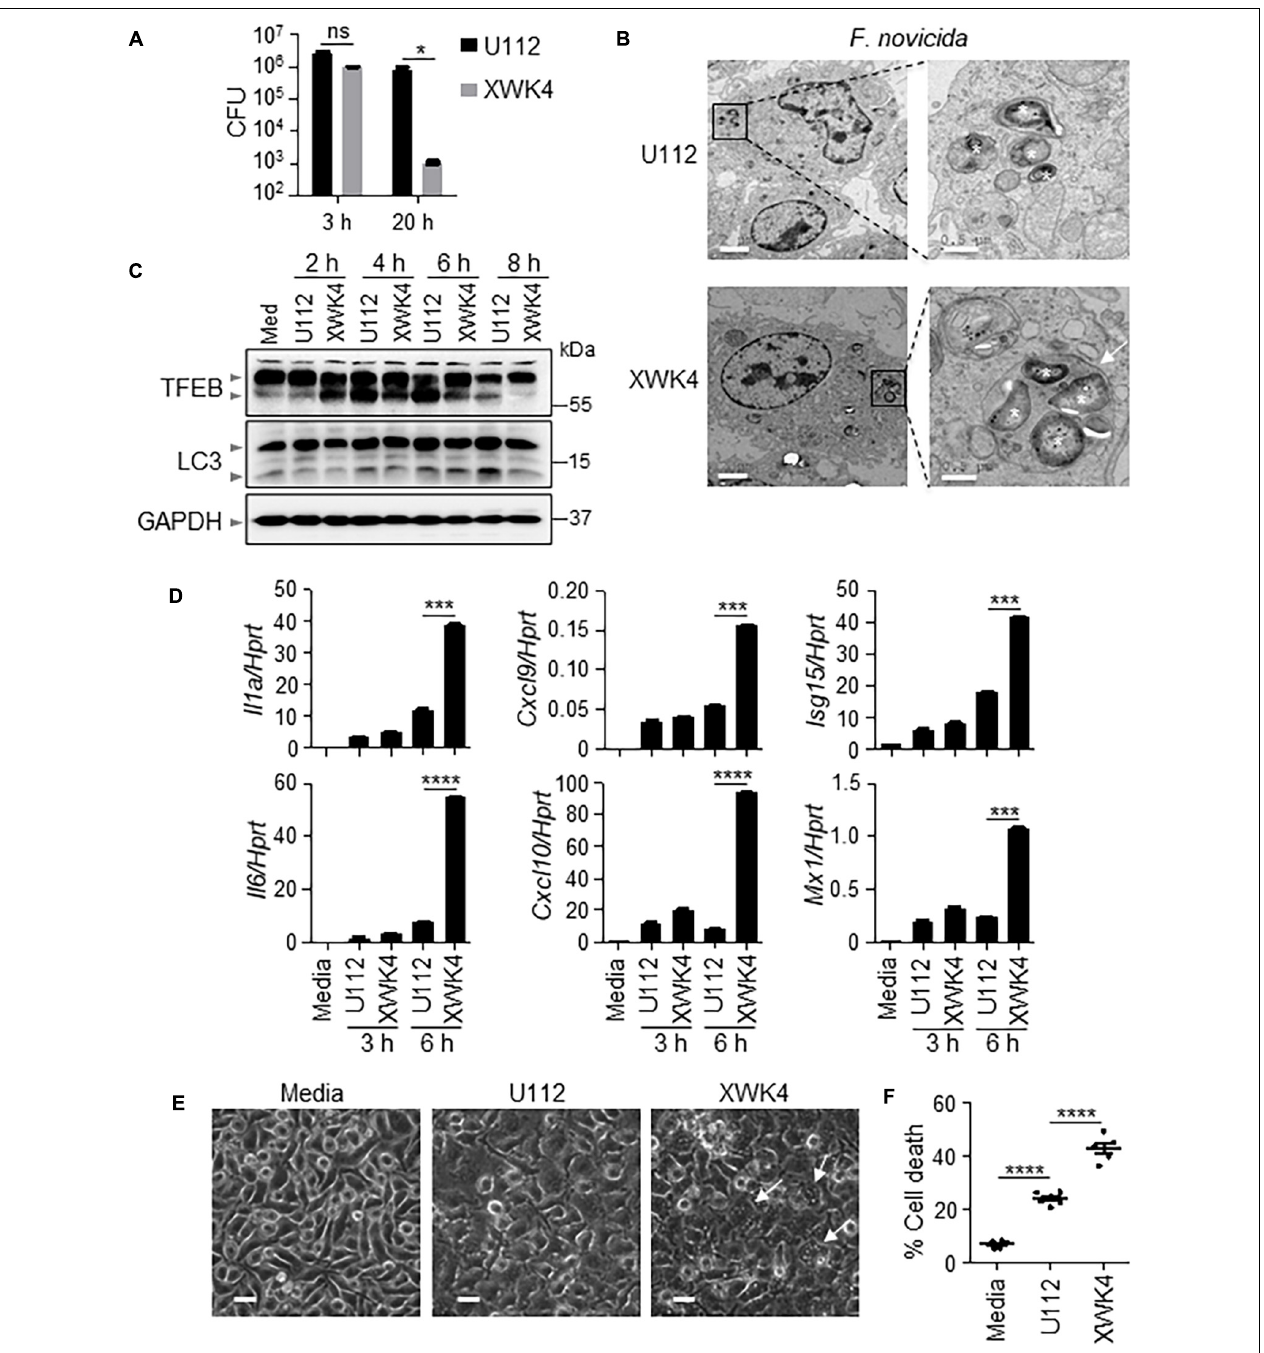
FIGURE 1 | F. novicida mutant strain XWK4 enhances inflammatory cytokines expression and cell death. (A) BMDMs from WT mice were infected with F. novicida WT strain (U112, 20 MOIs) and mutant strain (XWK4, 20 MOIs) for 3 h, and intracellular bacteria were enumerated at indicated times. (B) Transmission EM analysis of U112- and XWK4-infected (100 MOIs) BMDMs for 2 h. Asterisk indicates the individual intracellular bacteria. Arrow indicates the vesicle that contains multiple bacteria. Scale bars: 2 µ m for left and 0.5 µ m for right. (C) Immunoblot analysis of TFEB and LC3 in uninfected and U112- and XWK4-infected (100 MOIs) BMDMs at indicated times. (D) Expression of Il1a , Il6 , Cxcl9 , Cxcl10 , Isg15 , and Mx1 was analyzed by qRT-PCR in U112- and XWK4-infected (100 MOIs) BMDMs for indicated times. (E,F) Cell death was analyzed by microscope (E) and LDH release assay (F) for U112- and XWK4-infected (200 MOIs) BMDMs (14 h). Arrow indicates the dying cell. Scale bars: 20 µ m for (E) . Each symbol indicates individual sample for (F) . * p < 0.05; *** p < 0.001; **** p < 0.0001; ns, not significant (two-sided Student’s t -test without multiple comparisons correction). Data are representative of three independent experiments.